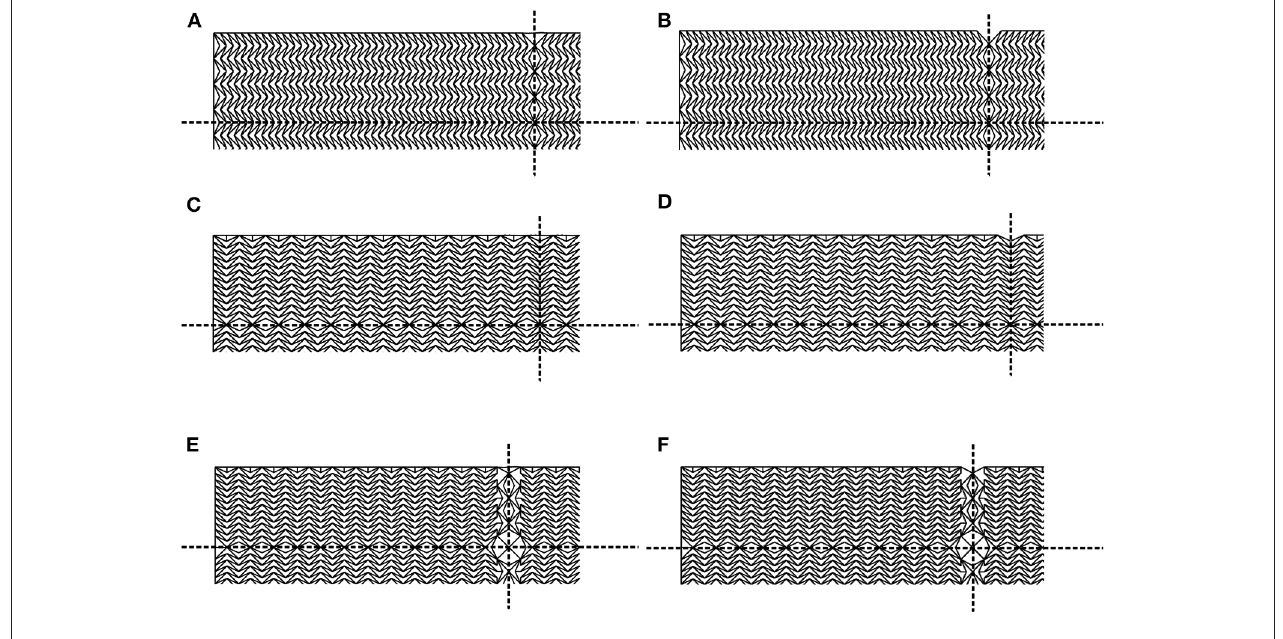
FIGURE 10 | Lattice cores with (A,B) horizontal, (C,D) vertical, and (E,F) both vertical and horizontal interruptions along the two dashed lines of symmetry, midspan, and mid-depth, respectively, labeled as: (A) AHBF MS , (B) AHBF ′ MS , (C) AVBF VS , (D) AVBF ′ VS , (E) AVHI 1 , and (F) AVHI ′ 1 . (A,C,E) are with face plate elements at midspan; (B,D,F) are the respective panels with the midspan face plate element has been